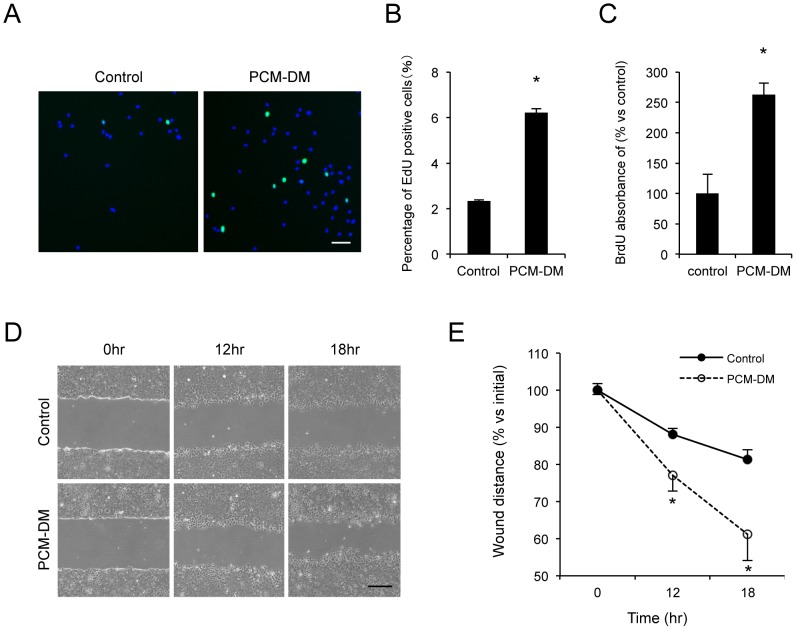
Effect of PCM-DM on the promotion of cell proliferation and migration.(A+B) To test the proliferative potential, the MCECs cultured on the PCM-DM were immunostained with 5-ethynyl-2 Click-iT® EdU Imaging Kits, and the percentages of EdU-positive cells were evaluated after 24 h of incubating with 10 µM EdU. The experiments were performed in duplicate. Scale bar: 100 µm; *p<0.01. (C) The MCECs were seeded at a density of 5.0×103 cells/well. The proliferation of the MCECs was evaluated by a BrdU incorporation assay after 24 h of incubating with 10 µM BrdU. The experiment was performed in duplicate. *p<0.01. (D+E) The MCECs were cultured for 14 days after reaching confluence, and the monolayer cells were wounded by scratching. After 12 and 18 h, the wound distance was quantified by Image J software (n = 10). The experiment was performed in triplicated. *p<0.01; scale bar: 200 µm.